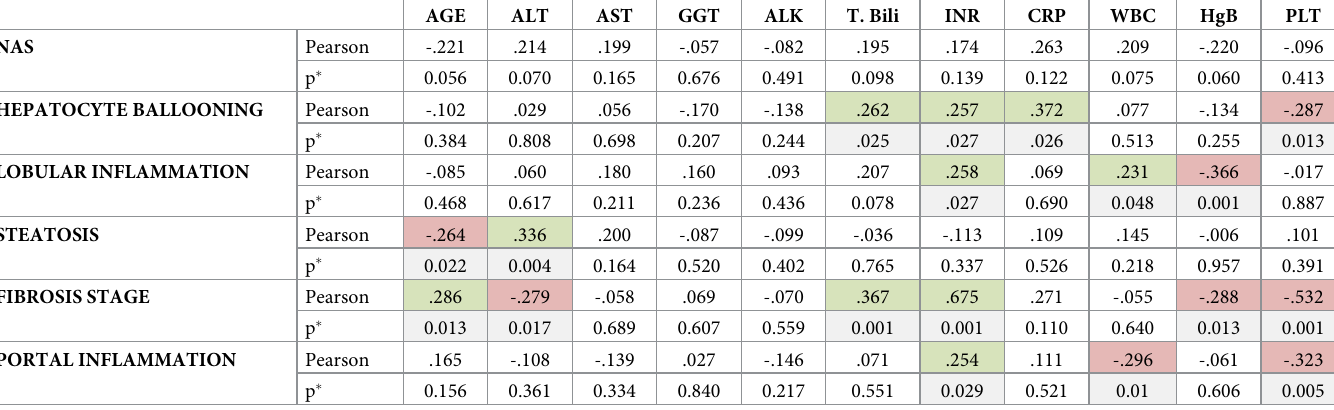
Table 4. Correlation of laboratory variables and age with NAS, NAS components, fibrosis stage and portal inflammation- univariate analysis.